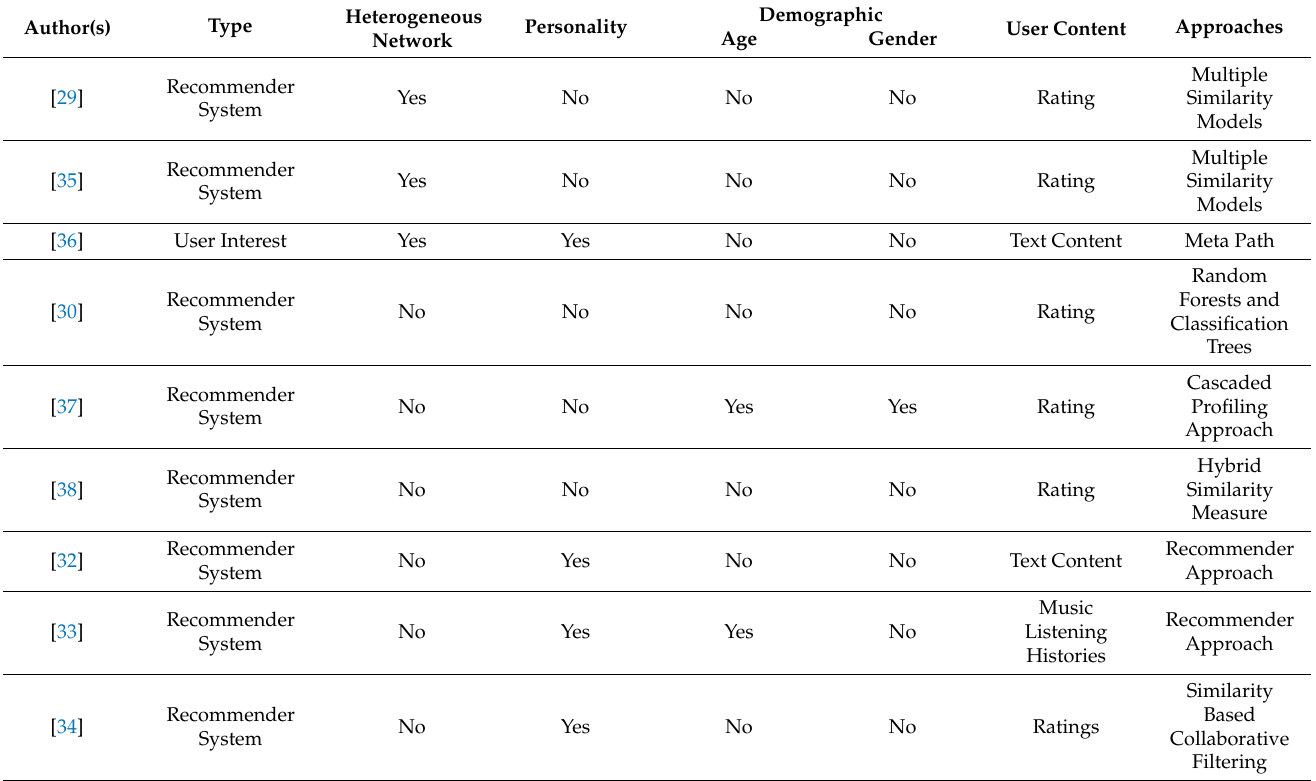
Table 1. Summary of important factors in the